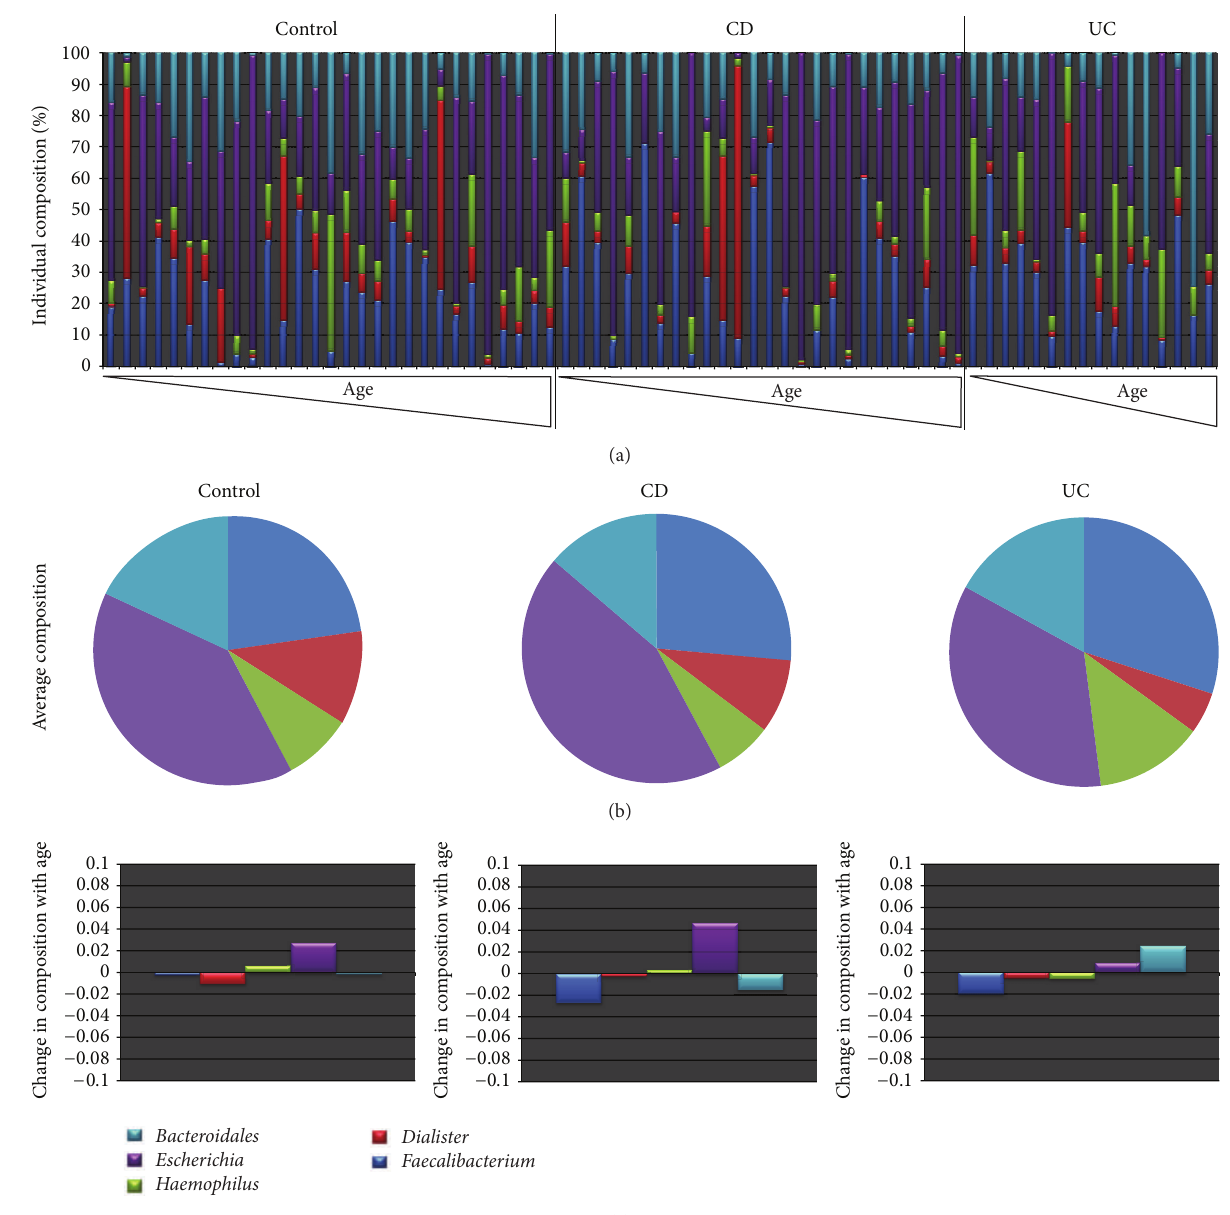
Figure 1: Composition of the gut microbiota as determined by MCR. (a) Individual distribution of the gut microbiota. (b) Average composition of the gut microbiota within the disease categories analysed. (c) Change of gut microbiota within disease categories with age.